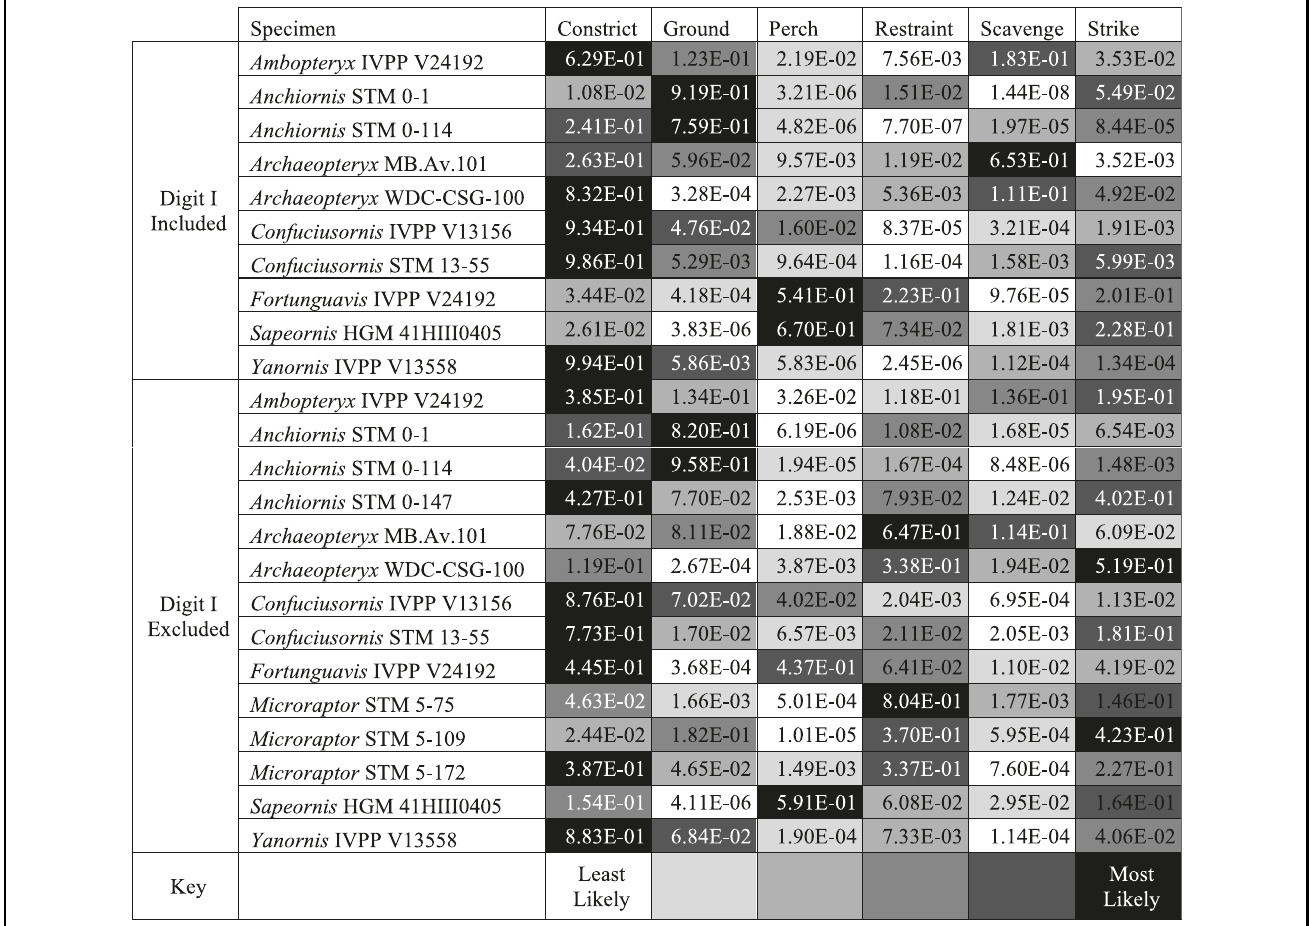
Values withdarker backgrounds aremore likely, valueswith lighterbackgrounds arelesslikely(see the ‘ Key ’ row). Ambopteryx , Confuciusornis , and Yanornis allhave claws most similar to specialised constricting raptors,followedbyground birds. Ecology isuncertainfor Anchiornis , with different specimensshowingaf fi nities forgroundbird, specialised constricting raptorial,